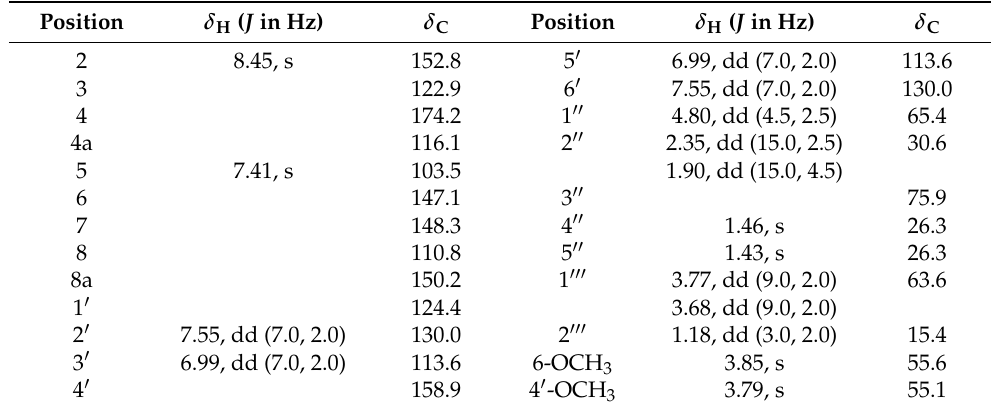
Table 1. 1 H (500 MHz) and 13 C (125 MHz) NMR spectroscopic data of 1 recorded in DMSO- d 6 ( δ in ppm).